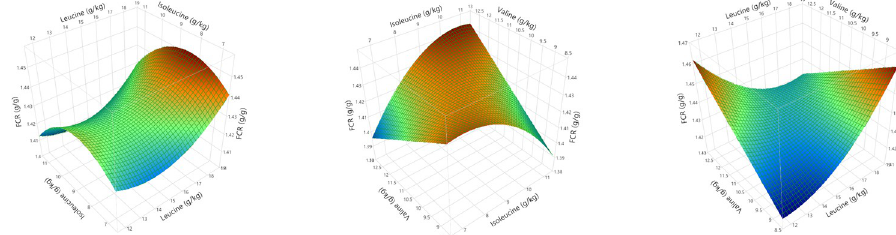
Fig 5. Response surfaces showing the relationship between feed conversion ratio (FCR) and dietary digestible branched chain amino acids in male broilers from 7 to 28 days post-hatch.